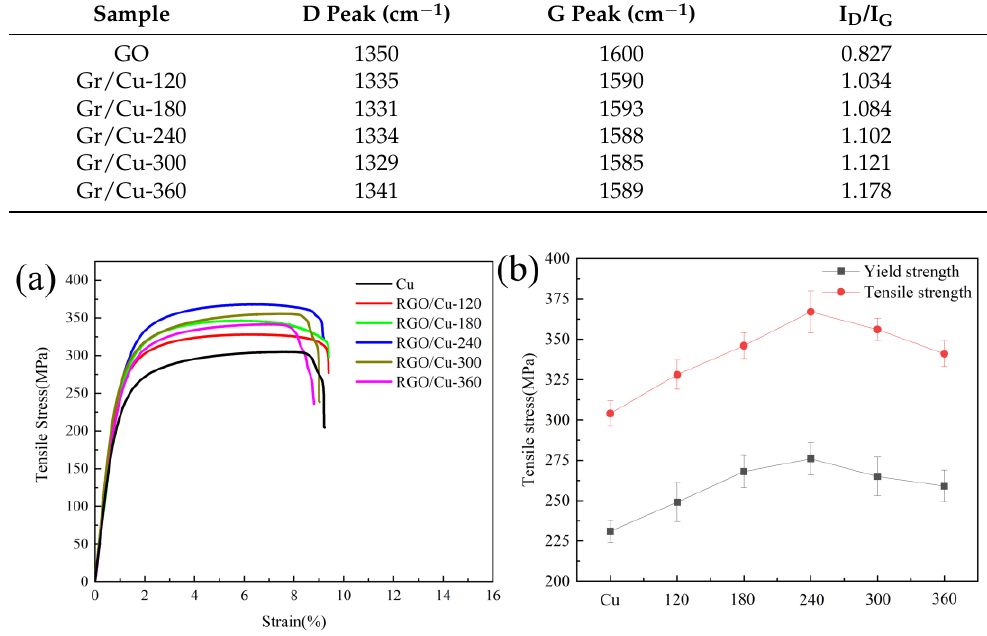
Figure 8. ( a ) Tensile stress–strain curves of Cu and Gr/Cu composite film with different deposition times of Gr, and ( b ) yield strength and tensile strength of Cu and Gr/Cu composite film with different deposition times of the Gr layer. Table 5. Yield strength, tensile strength, and elongation of Cu and Gr/Cu composite film with different electrodeposition times.